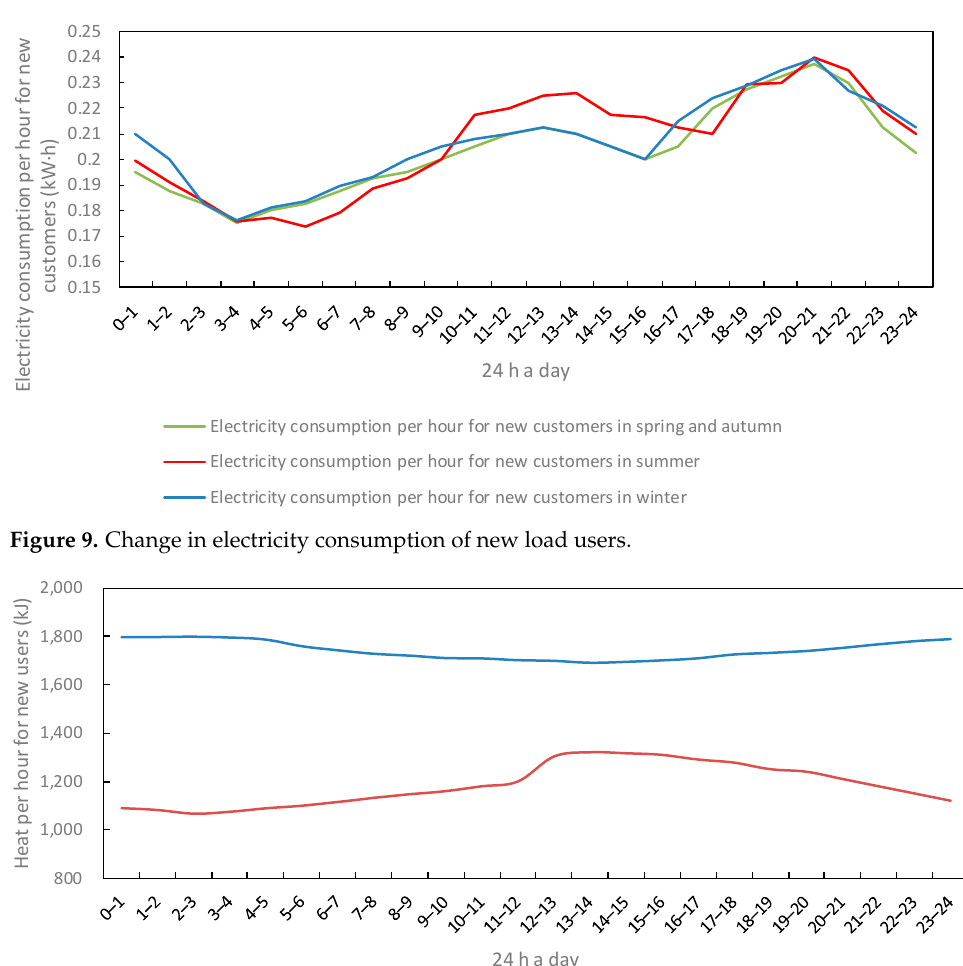
Figure 8. Change in electricity consumption of traditional load users.